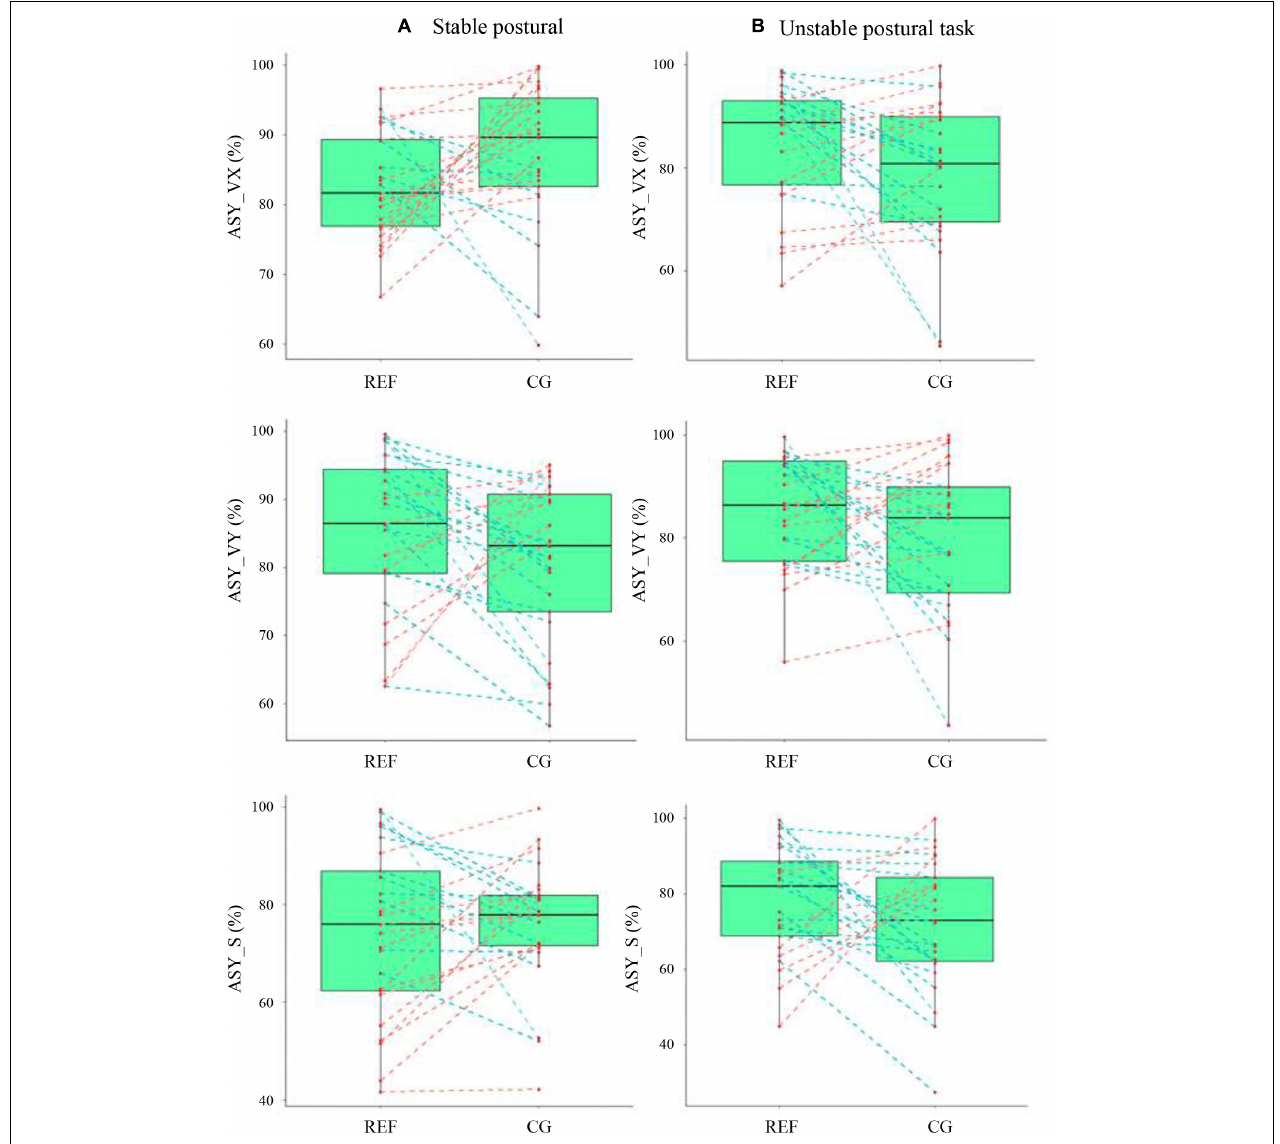
FIGURE 2 | Boxplot representation with individual data points of center of pressure asymmetry indexes in the reference (REF) and compression garments (CG) conditions in (A) the stable postural task and (B) the unstable postural task. The red dotted lines illustrate individuals whose asymmetry indices increase with CG while the blue dotted lines show individuals whose asymmetry indices decrease with